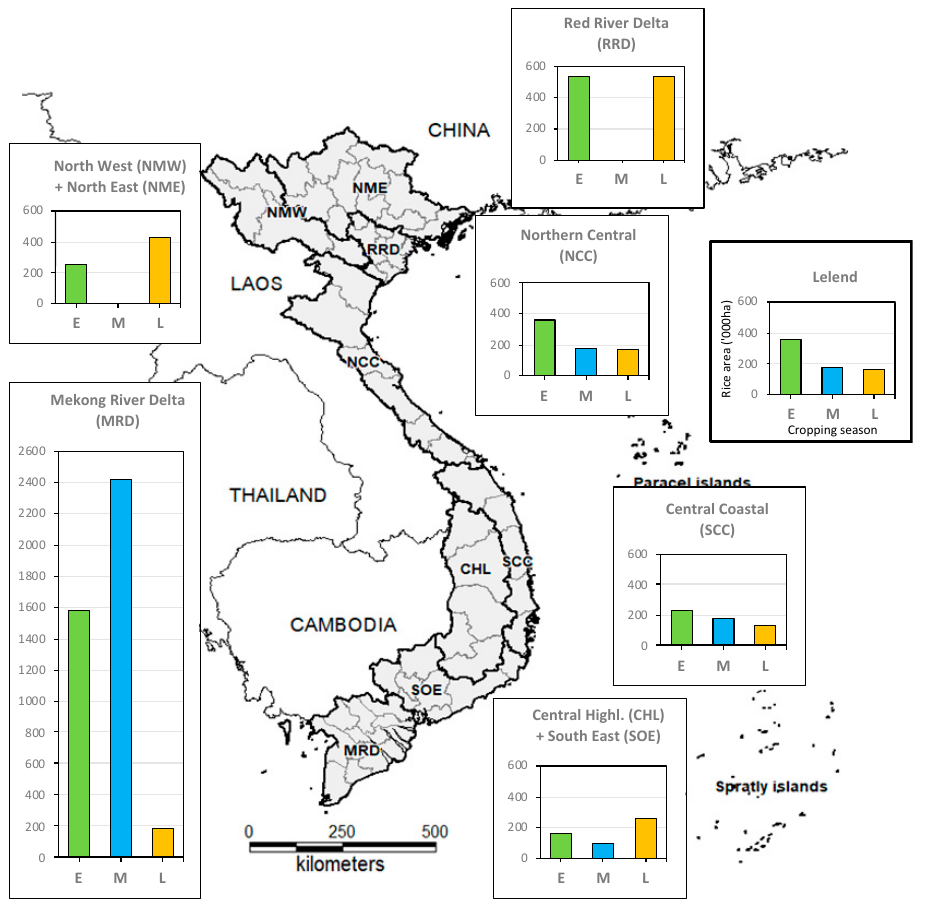
Figure 1. Distribution of rice area (in thousand ha) per region / agro-ecological zones (AEZ) and season in 2017 according to the General Statistics Office (GSO) [1]; rice crops in the early year (E), mid-year (M) and late-year (L) seasons are named spring, autumn and winter paddy in GSO statistics, respectively.